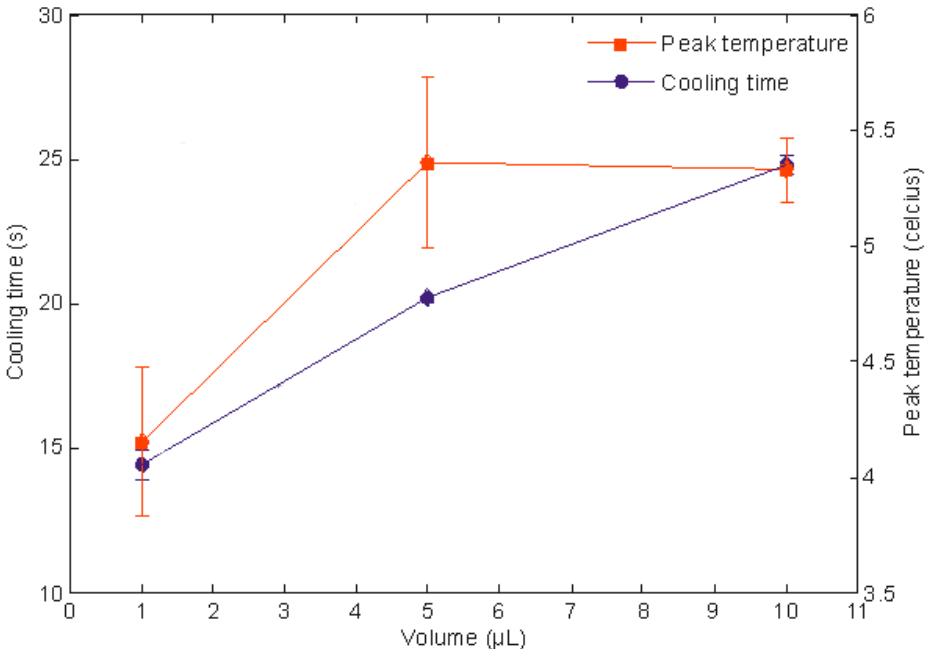
Figure 7. This graph shows the cooling time (blue line) and relative peak temperature (orange line) with reference to the volume of the droplets. The three dots and squares represent the volumes of 1, 5 and 10 μ L. In all three droplets, the iron oxide concentration and speed of the magnet are fixed at 0.01 g/mL and 4.65 mm/s,